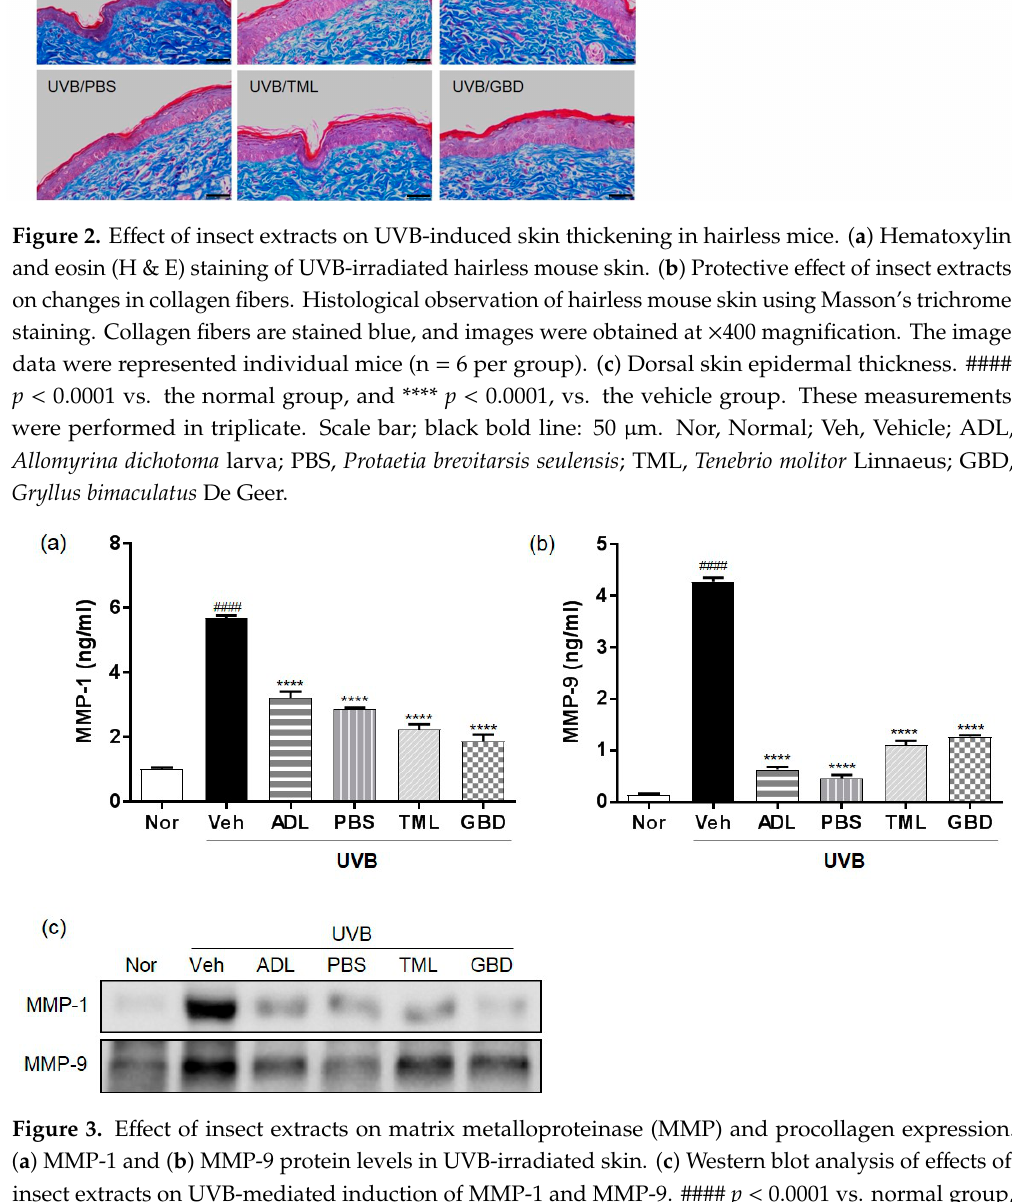
Figure 4. Effects of insect extracts on antioxidant activity with respect to ( a ) superoxide dismutase (SOD) and ( b ) catalase (CAT) in hairless mice skin exposed to UVB. #### p < 0.0001 vs. normal group, **** p < 0.0001 vs. vehicle group. These measurements were performed in triplicate. Nor, Normal; Veh, Vehicle; ADL, Allomyrina dichotoma larva; PBS, Protaetia brevitarsis seulensis ; TML, Tenebrio molitor Linnaeus; GBD, Gryllus bimaculatus De Geer. 3.5. Effects of Insect Extracts on MAPK Phosphorylation in UVB-Irradiated Hairless Mice It is well-known that the three subfamilies of the MAPKs pathway are extracellular signal- regulated kinase (ERK), c-Jun N-terminal kinase (JNK), and p38. To determine the regulation of the MAPKs pathways by the treatment of insect extracts, we analyzed the phosphorylation of MEK, ERK, JNK, and p38 by Western blotting. As shown in Figure 5, UVB irradiation induced the phosphorylation of MEK, ERK, JNK, and p38 in hairless mouse skin, while their total protein expressions showed no difference. In addition, the UVB-induced phosphorylation of MEK, ERK, JNK, and p38 was attenuated by the pretreatment of insect extracts.